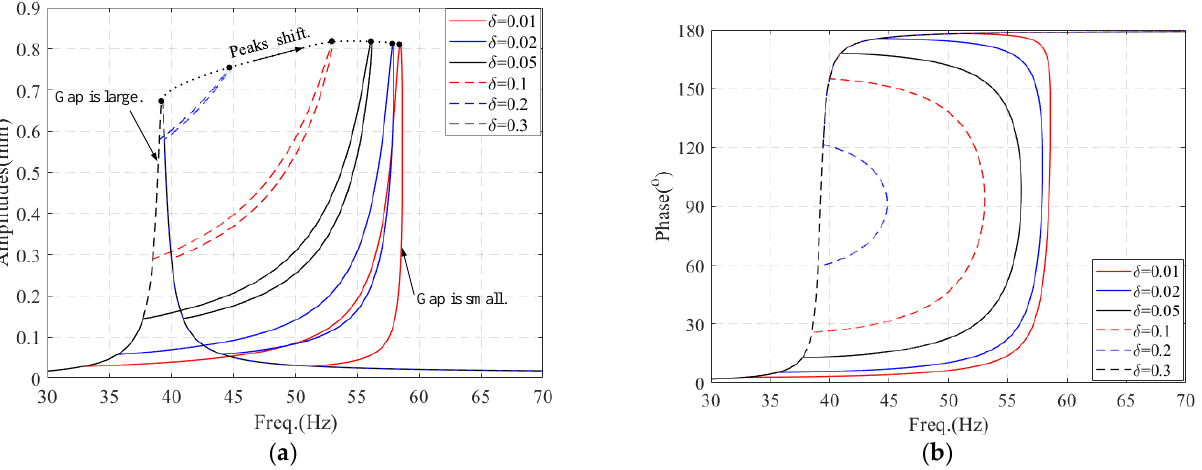
Figure 21. Amplitude – frequency and phase – frequency characteristics of the disk: ( a ) amplitude – frequency characteristics; ( b ) phase – frequency characteristics.